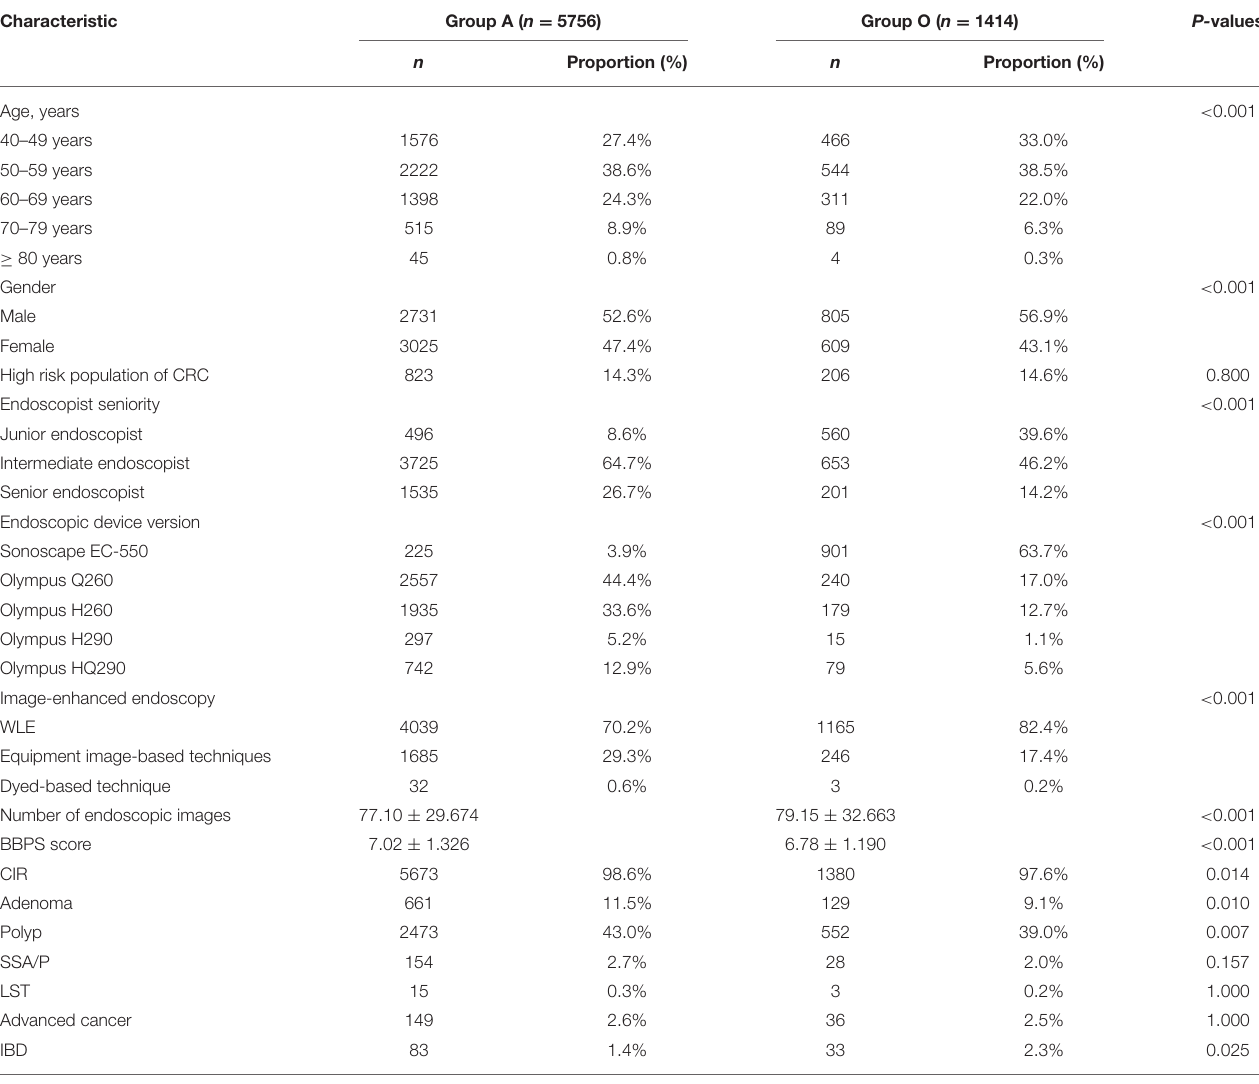
TABLE 1 | Patient characteristics of the total study cohort.